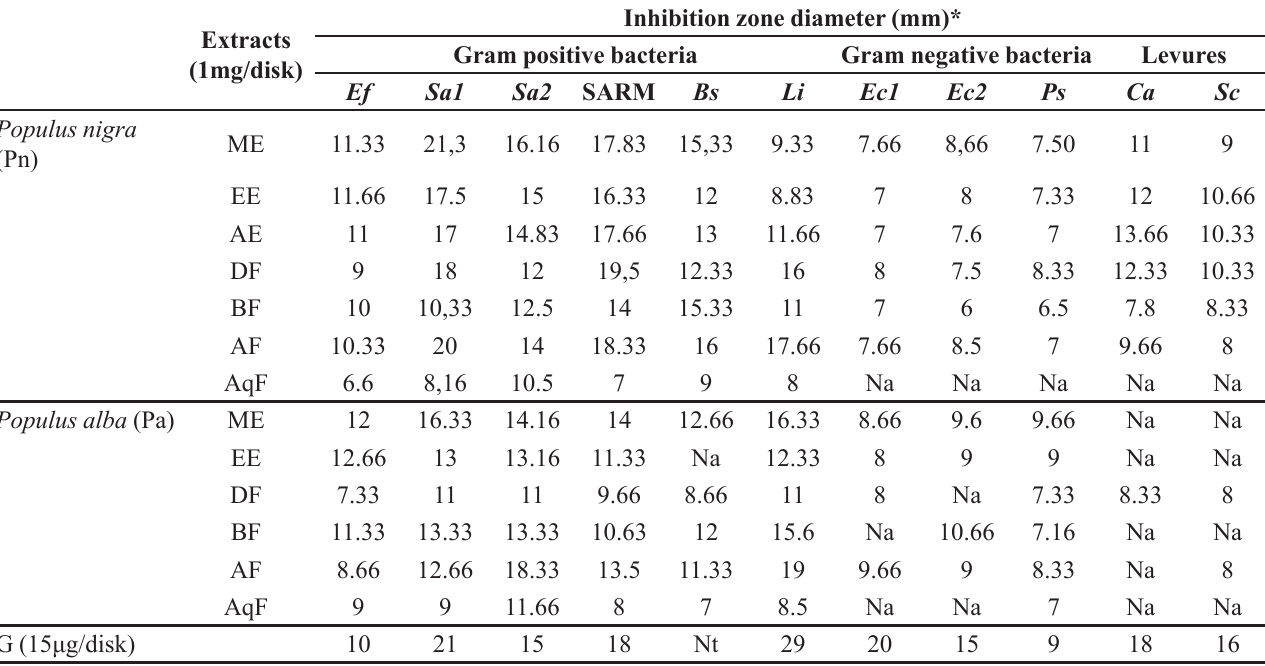
TABLE II - Antimicrobial activity of differents extracts through diffusion method on a solid medium